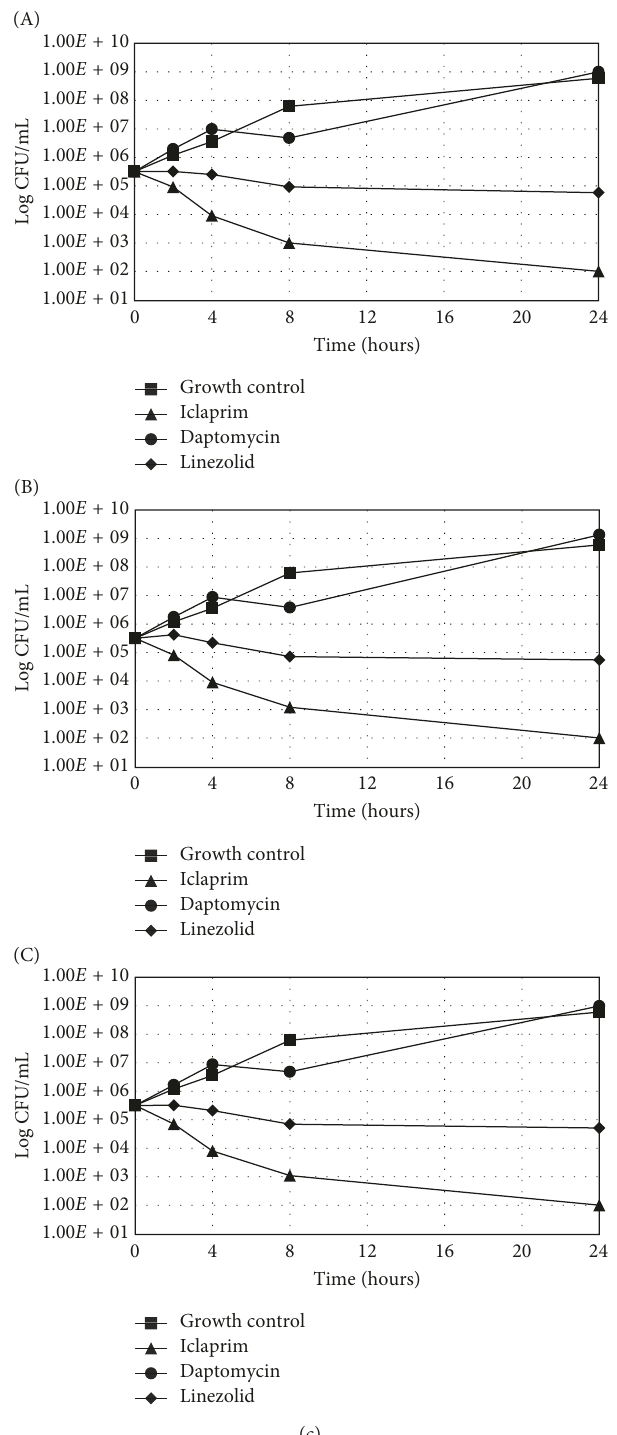
Figure 1: Iclaprim time-kill curves against MRSA isolates nonsusceptible to linezolid, resistant to vancomycin, and nonsusceptible to dap- tomycin, 2x, 4x, and 8x MICs were used for all antibiotics. (a) MRSA, linezolid nonsusceptible strain (MIC (A) 2x MIC. (B) 4x MIC. (C) 8x MIC. Iclaprim showed significantly lower CFU at 2h, 4h, 8h, and 24h compared to control, vancomycin,